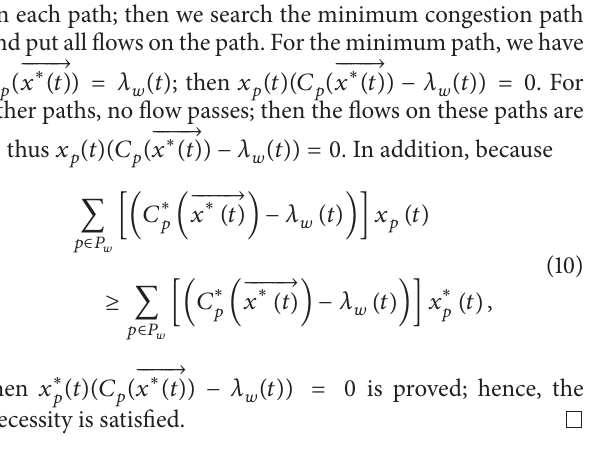
Figure 2: Five-link